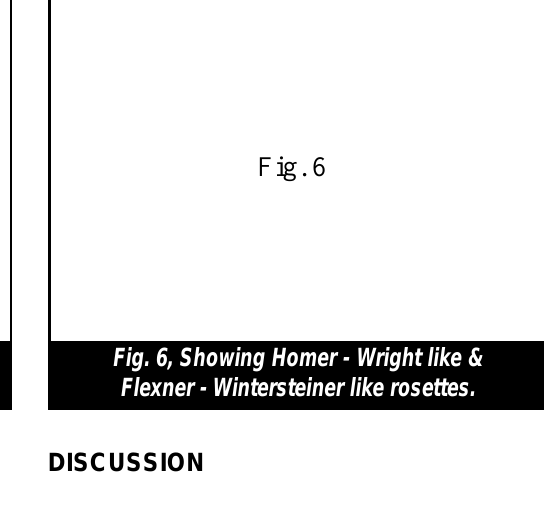
Flexner - Wintersteiner like